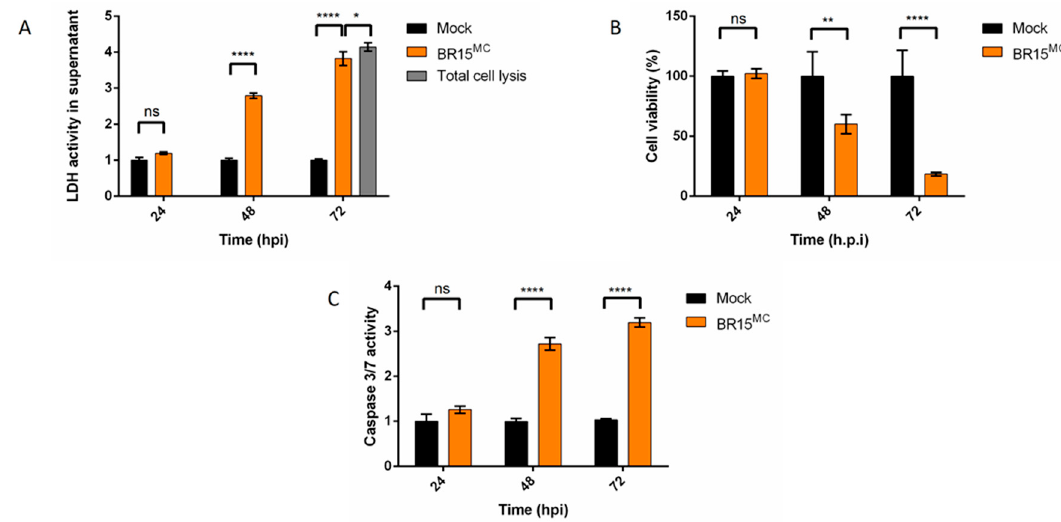
Figure 1. Cell death during a Zika virus (ZIKV) infection of A549 cells. A549 cells were infected with BR15 MC at a multiplicity of infection (MOI) of 1. LDH activity was measured in cell supernatant of mock infected cells, BR15 infected cells and in cells treated with triton X-100 as a positive control of total cell lysis value (grey bar) and was normalized to mock infected cells value ( A ), cell viability (MTT assay) ( B ) and caspase 3 / 7 activity ( C ) were measured at 24, 48 and 72 h post infection (hpi) and normalized to mock infected cells values. Values represent the mean and standard deviation of three independent experiments. Data were analyzed by a one-way ANOVA test with post-hoc Tukey’s test (* p < 0.05; ** p < 0.01; **** p < 0.0001; ns = not significant).